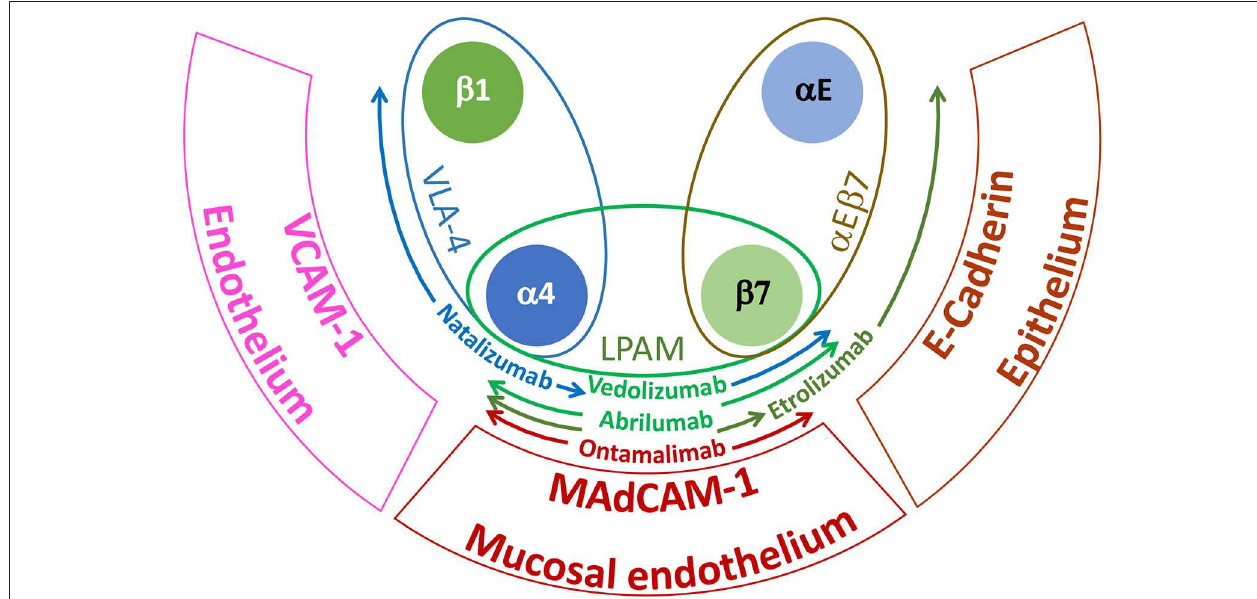
FIGURE 1 | Major integrins and tissue receptors involved in leukocyte homing during IBD. VLA-4 is expressed by most leukocytes, LPAM is specifically found on lymphocytes isolated from the gastrointestinal tract and α E β 7 is displayed by intraepithelial T cells. VCAM-1 is broadly expressed by inflamed endothelium; MAdCAM-1 is selectively expressed by high endothelial venules of Peyer’s patches and gut lymphoid tissues and E-cadherin is found on epithelial cells. Due to their specific target and epitope binding (see text), the indicated antibodies will be more or less selective for the gastrointestinal tissue and hence for IBD. Colored arrows indicate the spectrum of specificity for the different